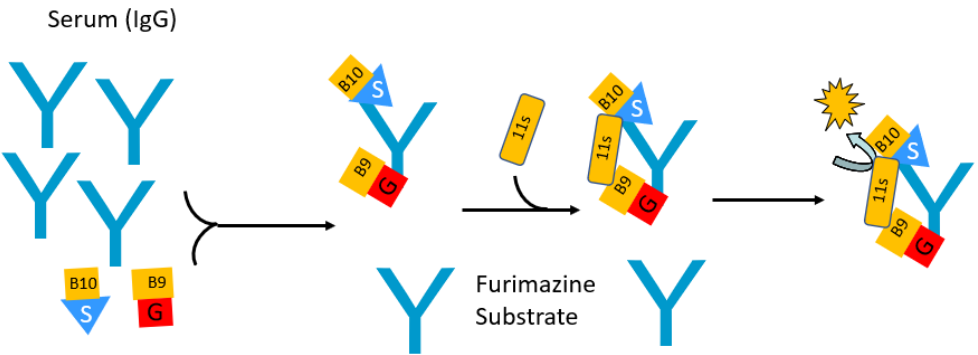
Figure 5. Three-component split luciferase assay (SATiN) for detecting antibodies. Three split nanoluciferase fragments are utilized. The small nanoluciferase β 10 fragment is generated as a fusion protein with the target antigen. A second β 9 nanoluciferase peptide is made as a fusion with the Fc immunoglobulin capturing protein G. When these two components are added with serum if the antibodies are present against the target, the Fab portion of the IgG will bind the β 10-spike antigen fusion (yellow and blue) and subsequently the β 9-protein-G fusion (yellow and red) will be captured by the Fc portion of the same immunoglobulin molecule. To complete the reaction a third large nanoluciferase fragment (D11S) is added. This completes the proximity bridge and upon addition of furimazine substrate produces light. Light production is proportional to amount of antibody